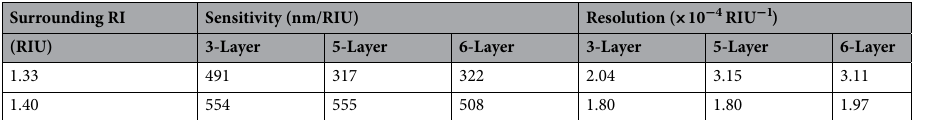
Table 1. Refractometric performance of the three fabricated structures based on few-layer 1DPC deposited on D-shaped.